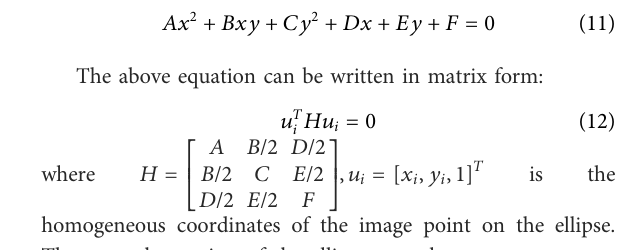
FIGURE 5 Principle of binocular stereo vision